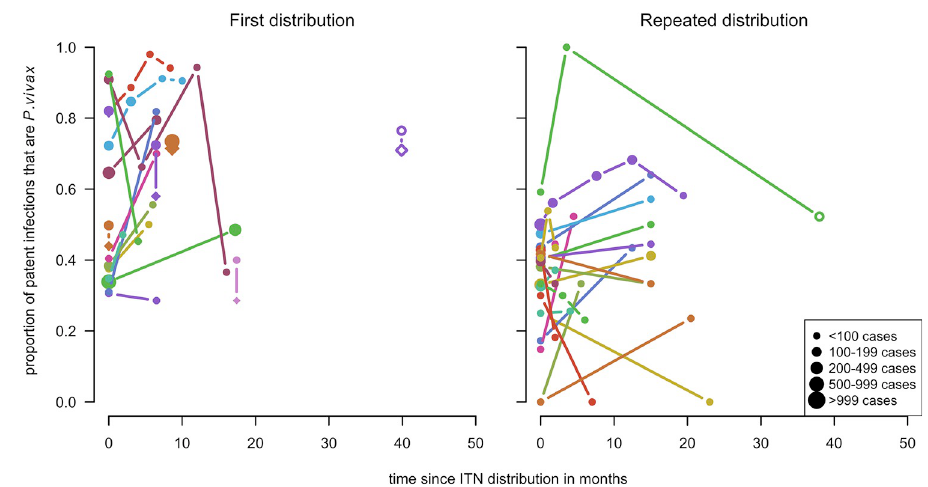
Fig 14. Spaghetti plots splitting the series of time-points of the proportion of patent infections that are P. vivax by round of ITN distribution. Excluding series of time points that have no measurement within 24 months after the intervention. Dot size depending on number of